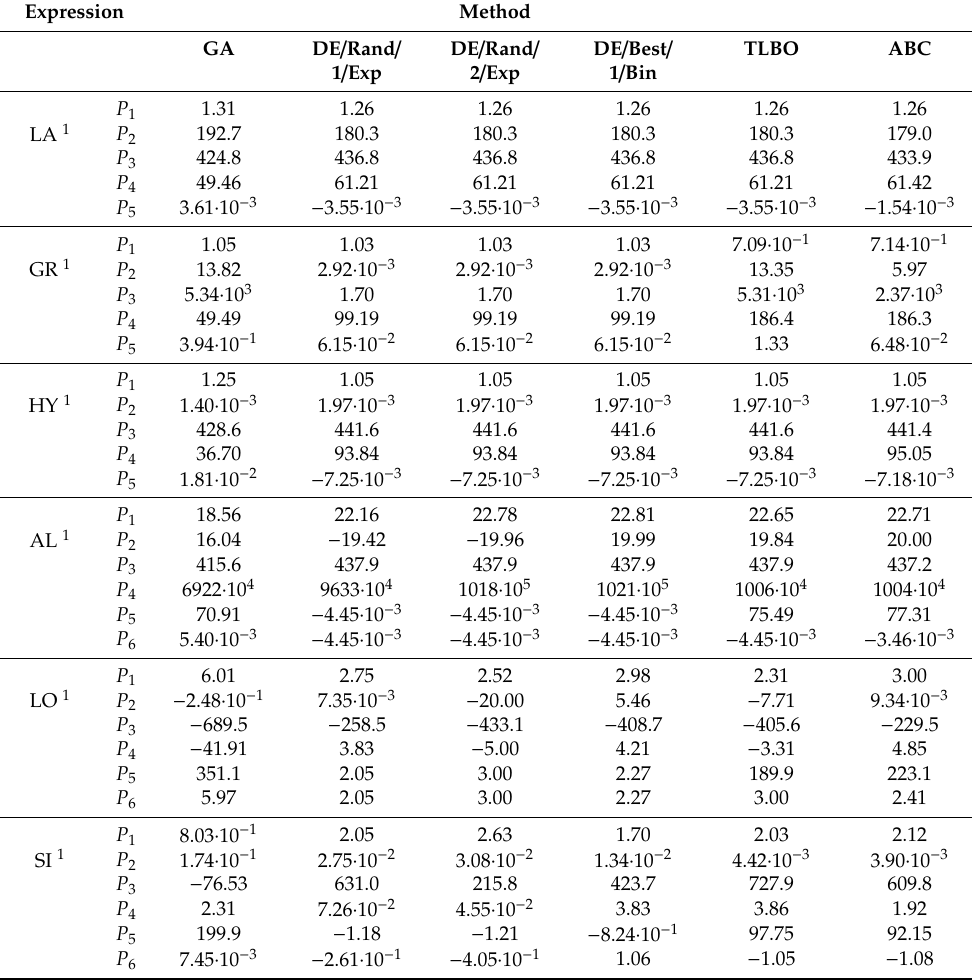
Table 4. Parameters of expressions for the results (best OF) from Table 2 for